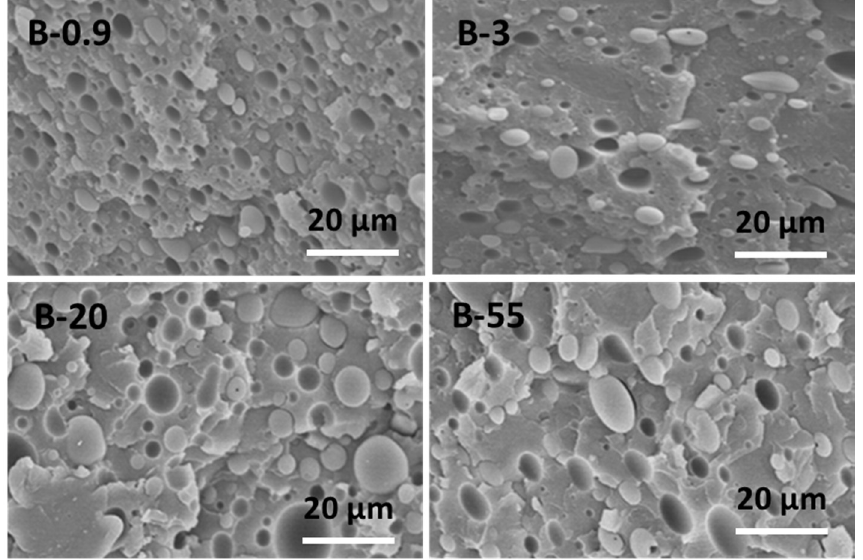
Figure 1. SEM micrographs of cryogenically fractured surfaces of PS80 / PP20 blends with di ff erent viscosity ratios ( K ) in the transverse direction.